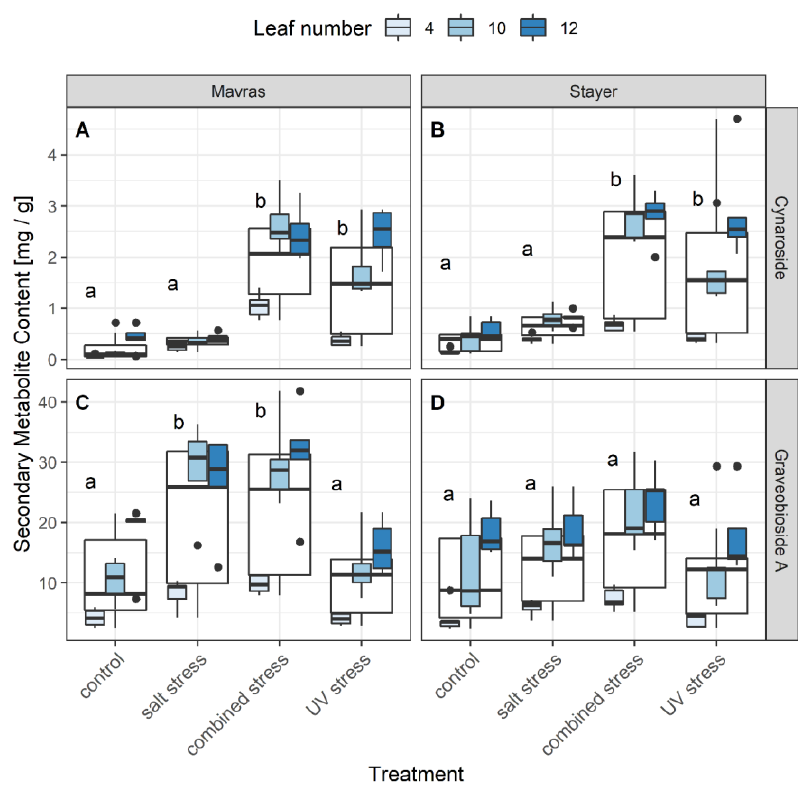
Figure 1. HPLC-determined leaf cynaroside ( A , B ) and graveobioside A ( C , D ) contents, for bell pepper cultivars ‘Mavras’ ( A , C ) and ‘Stayer’ ( B , D ) under different growth conditions, 15 days after treatment inception ( n = 5). Transparent boxplots show pooled data from all leaves ( n = 15). Colored boxplots represent leaf age — subgroups (Leaf 4, 10, and 12 as counted from the base, with darkest colors for youngest leaves). Letters (a,b) indicate differences within each cultivar × secondary metabolite — combination (Tukey HSD, p < 0.05).